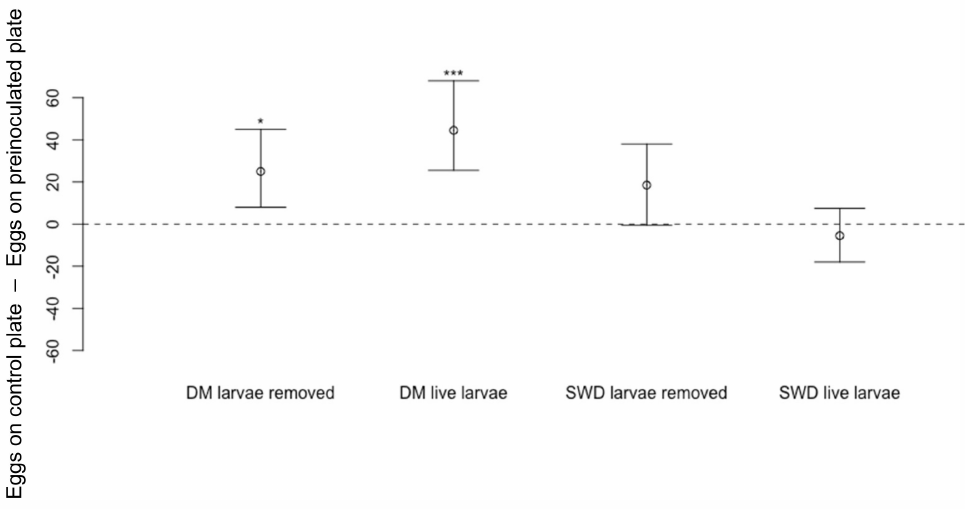
Figure 10. Differences in numbers of eggs laid by Drosophila suzukii (Median ± 95% confidence intervals) on cornmeal media dishes previously fed upon by D. melanogaster (DM) larvae for 48 h and then removed ( n = 18, p < 0.05 *) or containing live larvae of D. melanogaster ( n = 18, p < 0.001 ***) compared to numbers laid on a blank dish. There were no significant differences between the numbers of D. suzukii eggs recorded on cornmeal media dishes previously fed on by D. suzukii (SWD) larvae ( n = 18, p = 0.06) or containing live D. suzukii larvae ( n = 18, p =